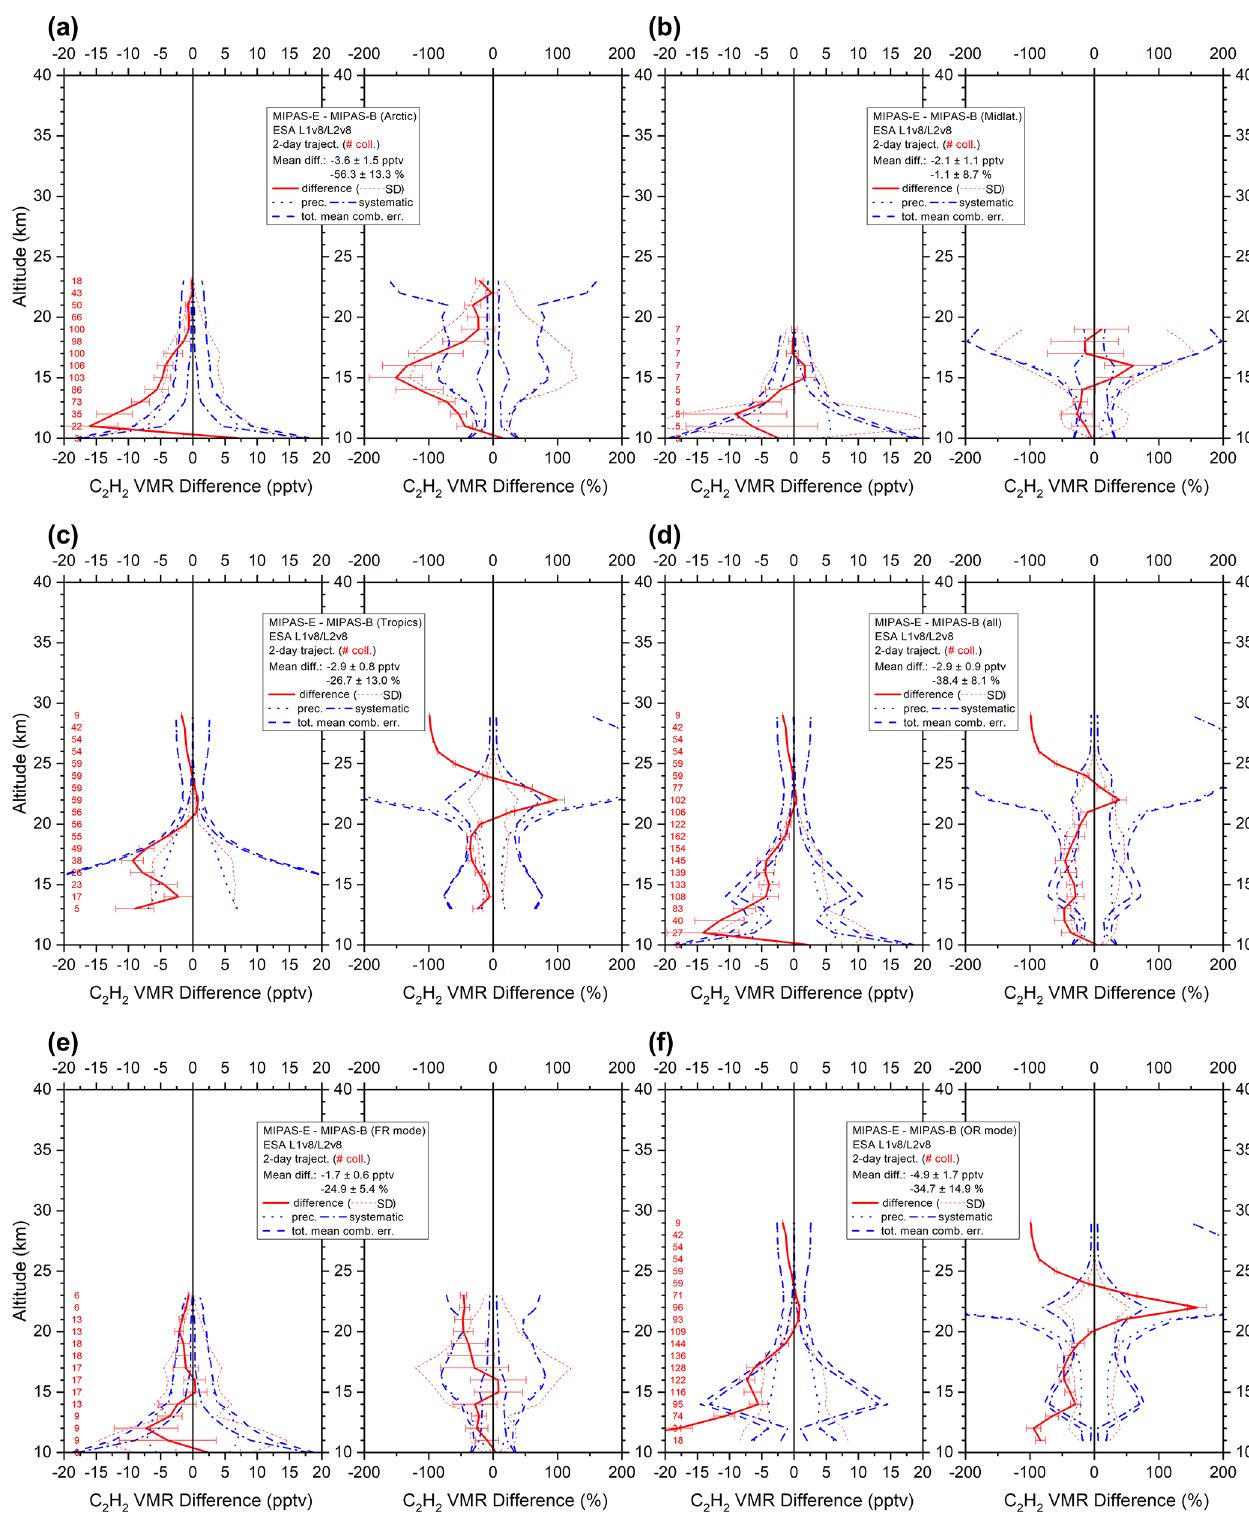
Figure 18. Same as Fig. 3 but for C 2 H 2